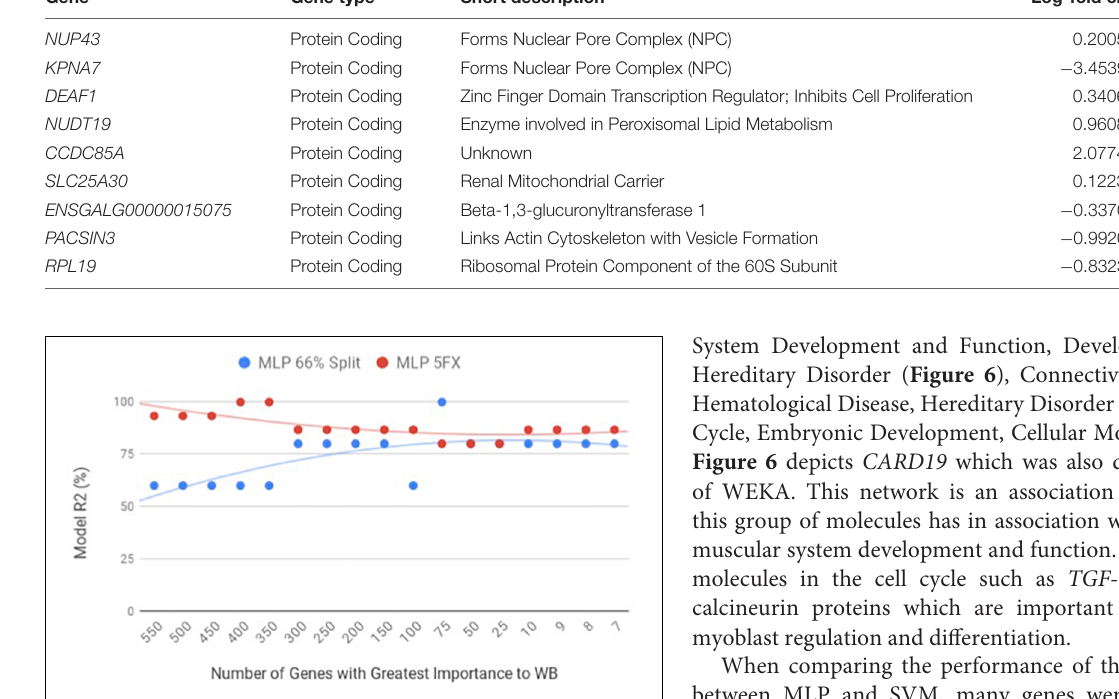
FIGURE 2 | WB Liver transcriptome dataset by 5x cross-validation and 66% percent split using Multilayer Perceptron (MLP).